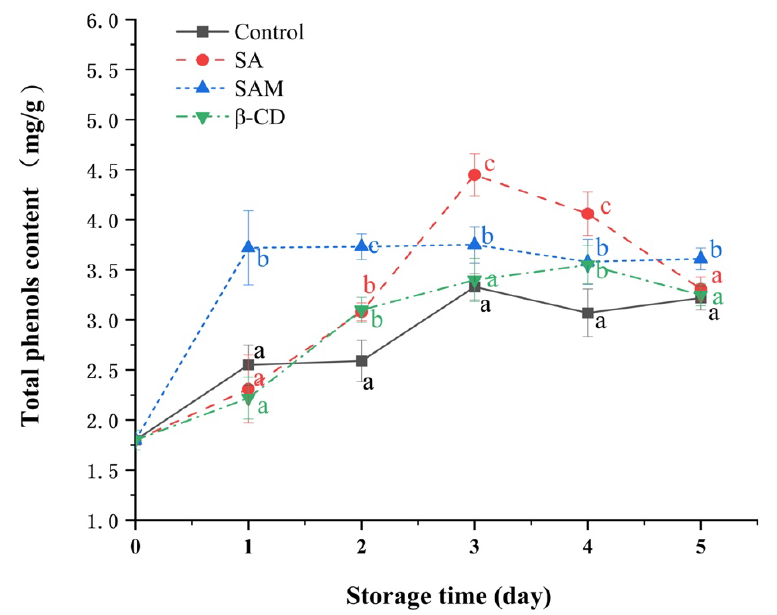
Figure 4. Effect of SAM on total phenolic contents in ‘Fuji’ apple during 5 days of storage at 25 °C. SA, salicylic acid; SAM, salicylic acid microcapsule; β -CD, β -cyclodextrin. Control group was prepared with sterile distilled water. Vertical bars represent standard errors. Different letters within each day show a significant difference ( p < 0.05).